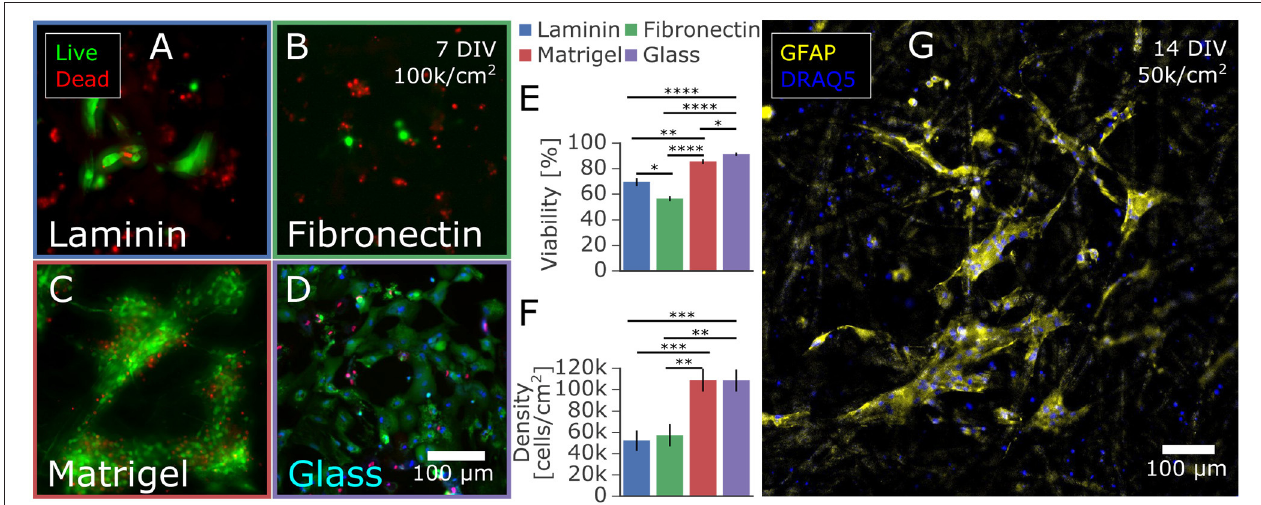
FIGURE 1 | Astrocytes isolated from primary rat cortex and cultured on paper-based substrates. (A–D) Influence of extracellular matrix protein coatings on astrocyte proliferation and viability at 7 DIV. Astrocytes were seeded at 100,000 cells/cm 2 on paper coated with (A) laminin, (B) fibronectin, or (C) Matrigel and on a control of (D) laminin-coated glass. After 7 days in culture with medium containing 10% FBS, the cells were stained with a live/dead viability assay. The cells on Matrigel-coated paper had the highest (E) viability and (F) number of adhered cells likely due to proliferation and/or adhesion properties in comparison to fibronectin and laminin coated paper. (G) Immunostaining with the astrocytic marker GFAP confirmed the astrocyte phenotype of the majority of rat cortex derived cells cultured for 14 days on Matrigel coated paper. Significance levels: * p < 0.05; ** p < 0.005; *** p < 0.0005; **** p < 0.00005.